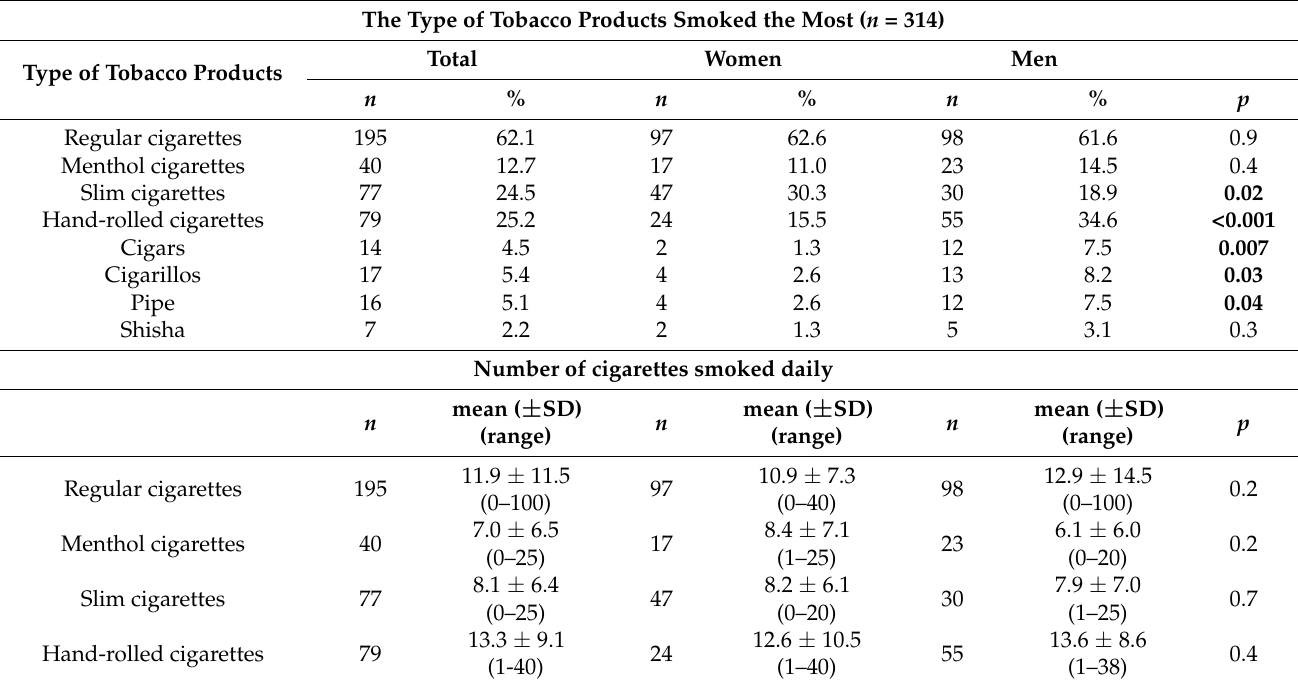
Table 2. Type of tobacco products used by the smokers n =